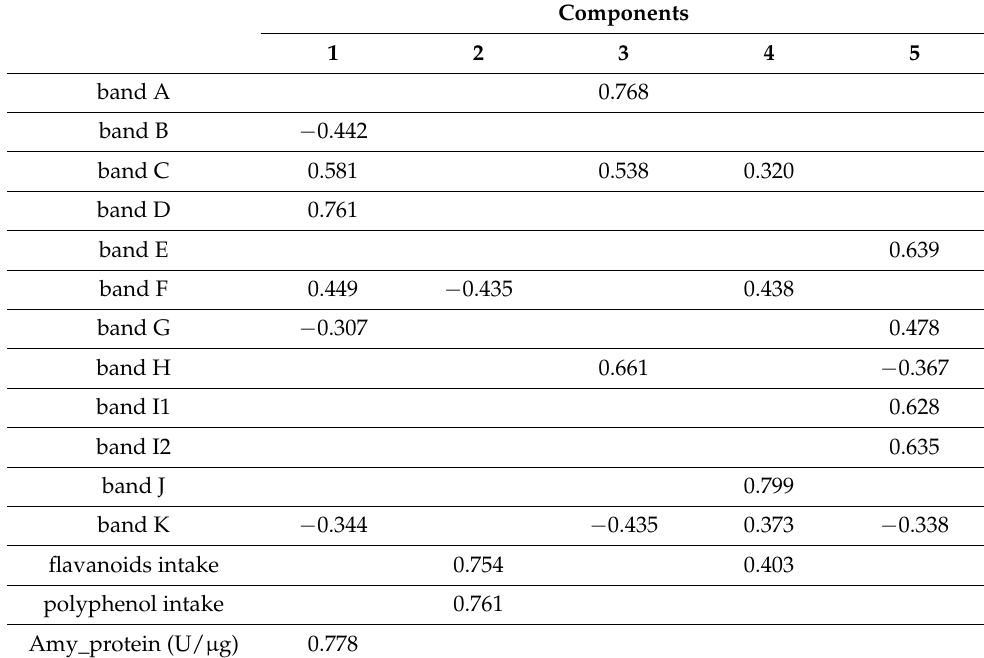
Table 2. Component loadings obtained by principal component analysis and Oblimin rotation of the saliva composition and flavonoids and polyphenol intake .